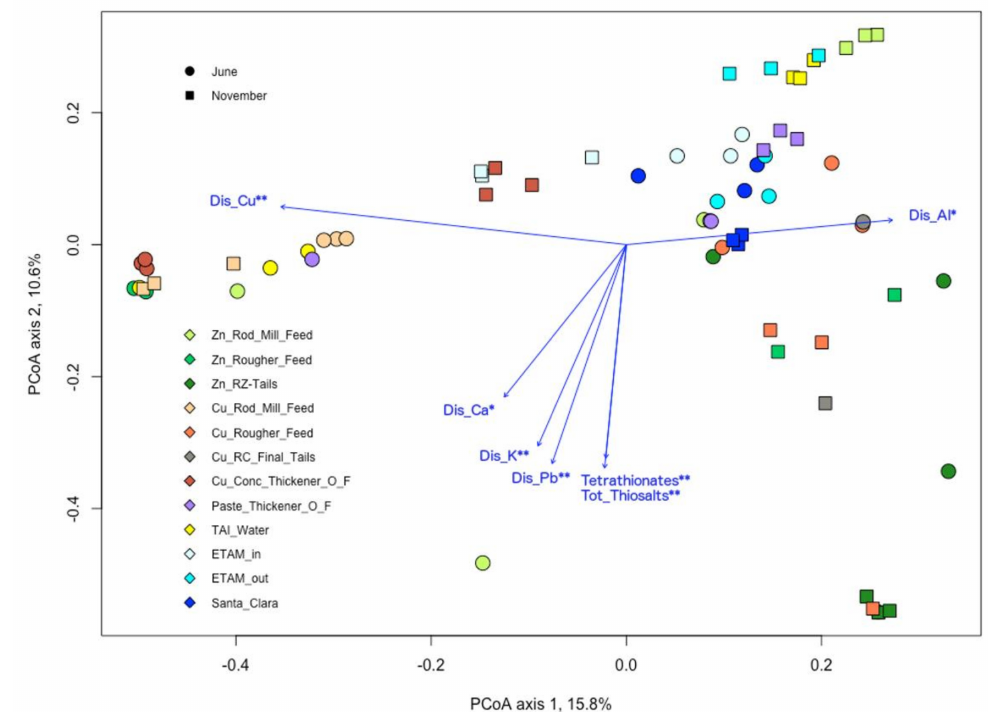
Figure 14. Principal coordinate analysis (PCoA) of the fungal communities identified from the Portuguese mine zinc and copper plants and water circuit samples by amplicon sequencing. Statistically significant (* p < 0.01, ** p < 0.001) chemical variables with 9999 permutations are